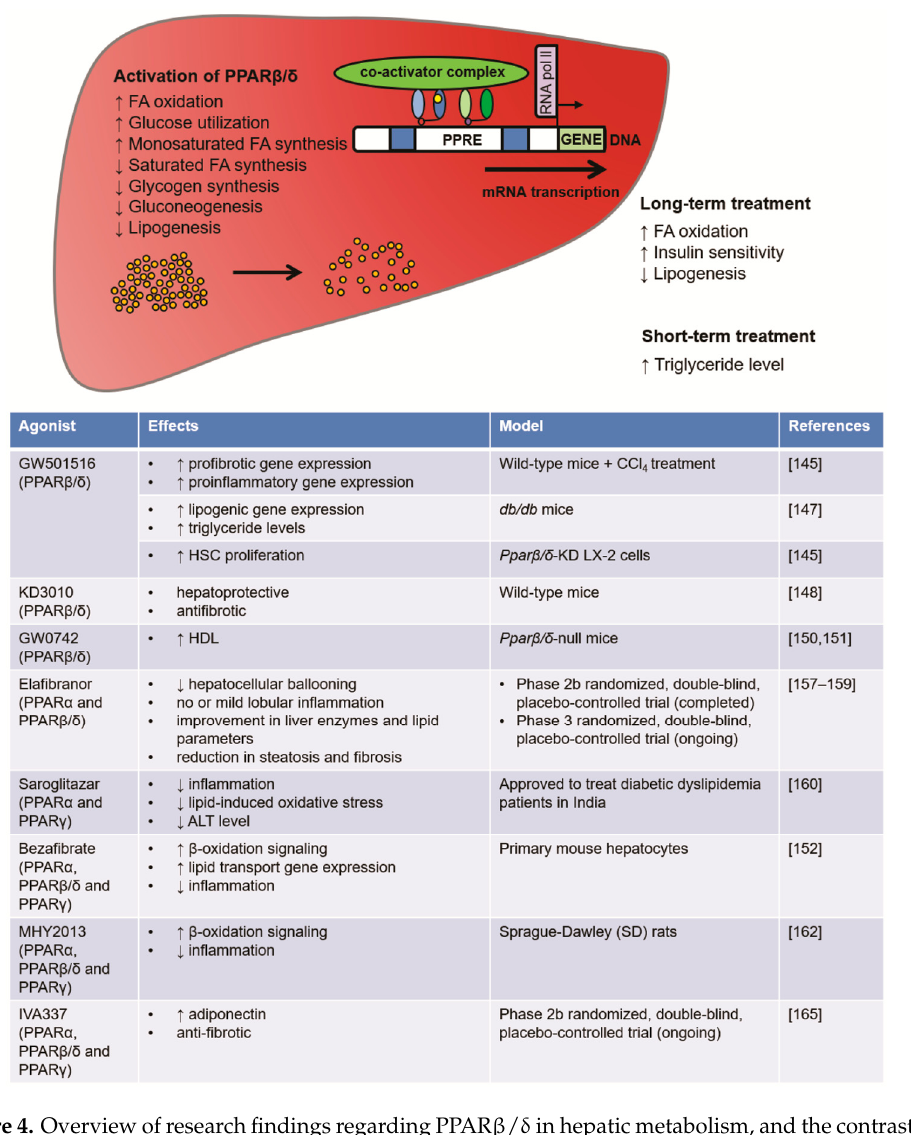
Figure 4. Overview of research findings regarding PPAR β / δ in hepatic metabolism, and the contrasting effects of various PPAR β / δ agonist treatments in pre-clinical models.